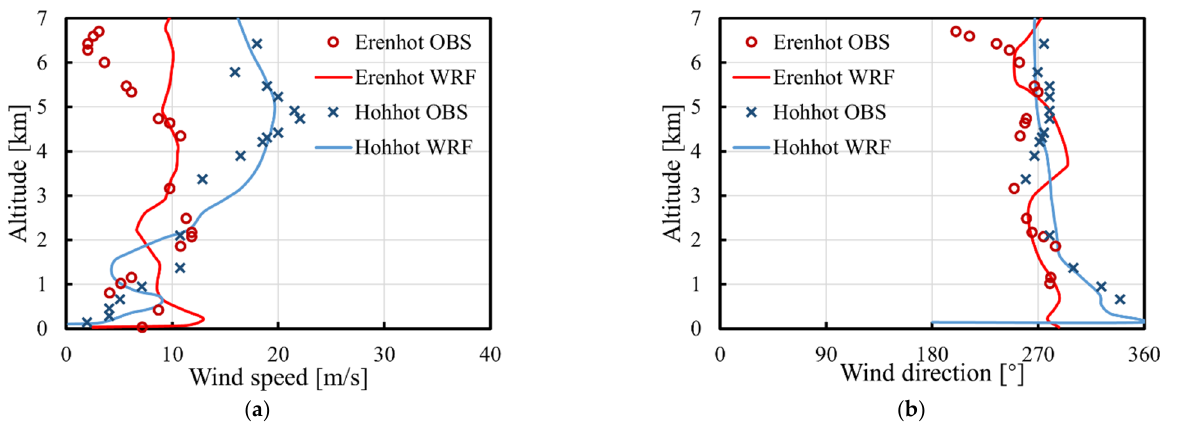
Figure 13. Profiles of ( a ) wind speed and ( b ) wind direction above the main landing area from WRF and upper-atmosphere sounding data at 12:00 LST on 25 June 2013.